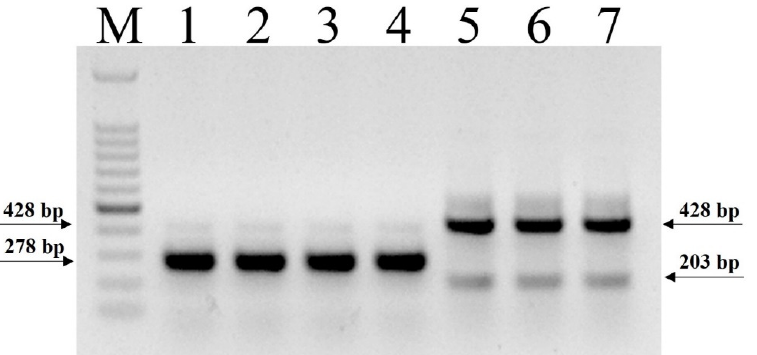
Figure 2. Tetra ‐ primer ARMS PCR products. M: 100 bp marker. Lanes 1 ‐ 7: Badila ‐ CN, LA Purple, 51NG63, 57NG208, Yunnan82 ‐ 114, SES208, Nepal2013 ‐ 6, respectively.